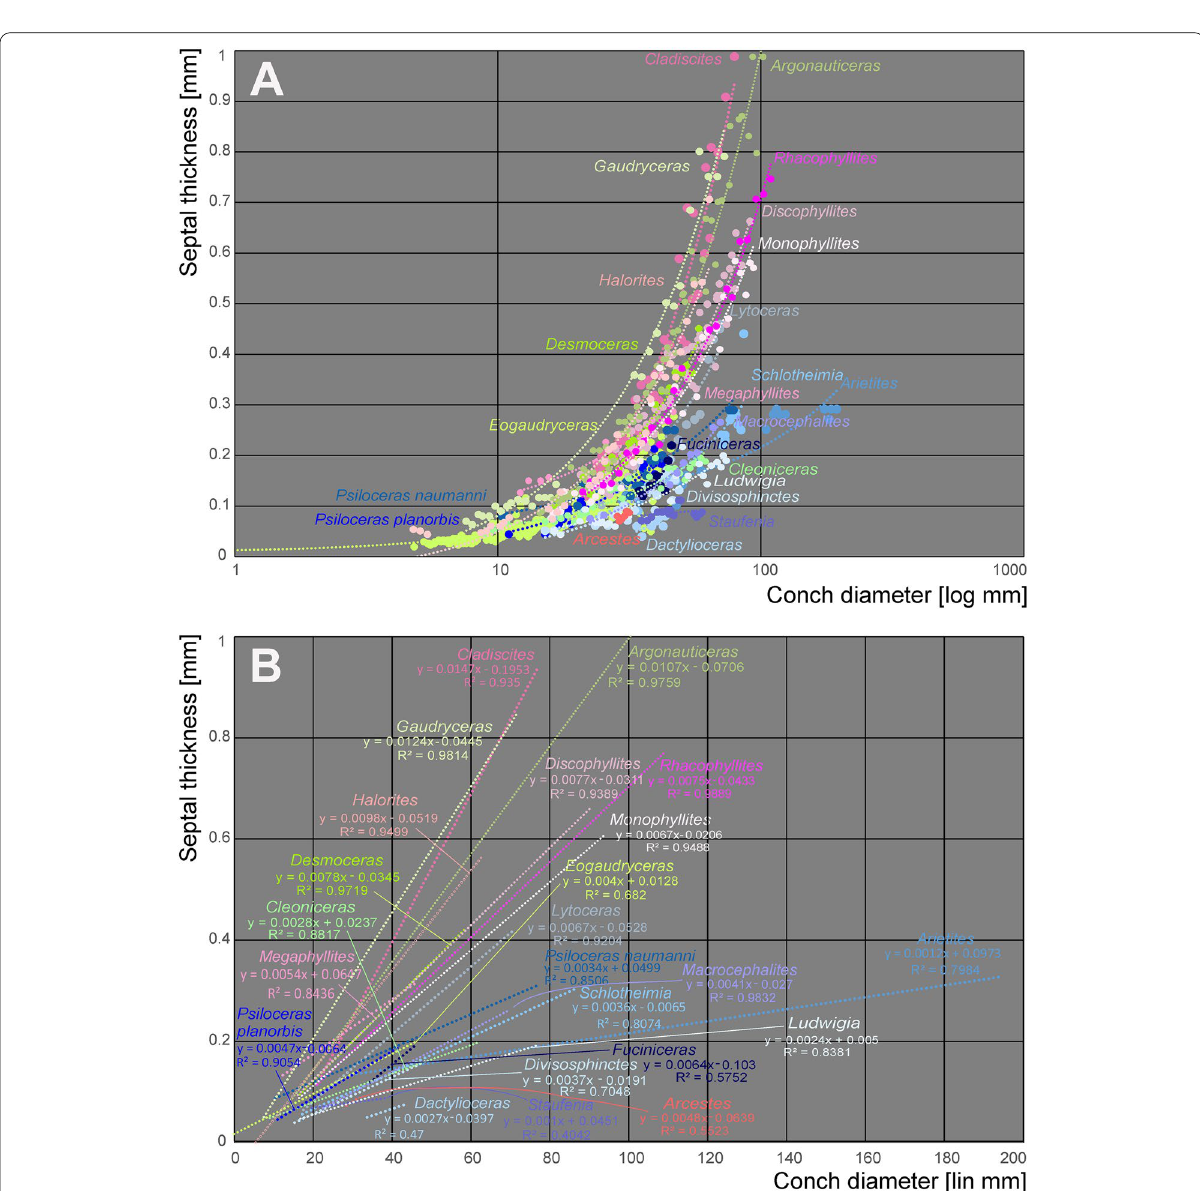
Fig. 8 A Semilogarithmic biplot of septal thickness versus conch diameter at the measured septa position for all ammonoid genera included. The dashed lines indicate the linear regression lines for each ammonoid family, which are represented by specific colours. B Linear biplot of the same data, but only displaying the linear regression lines with their equation and R